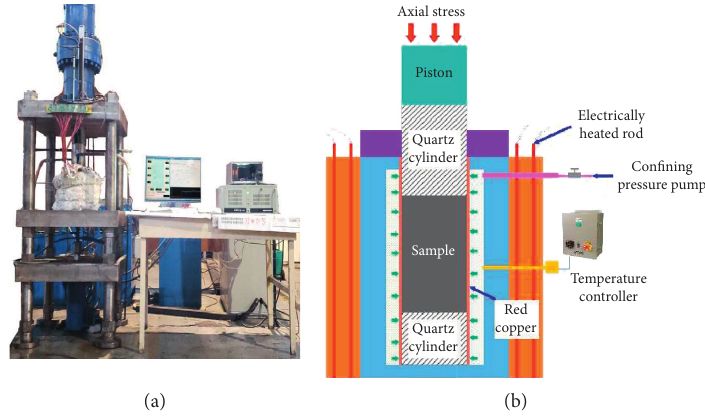
Figure 2: (a) Servocontrolled high-temperature test machine IMT-HTP100F. (b) Sample assembly.